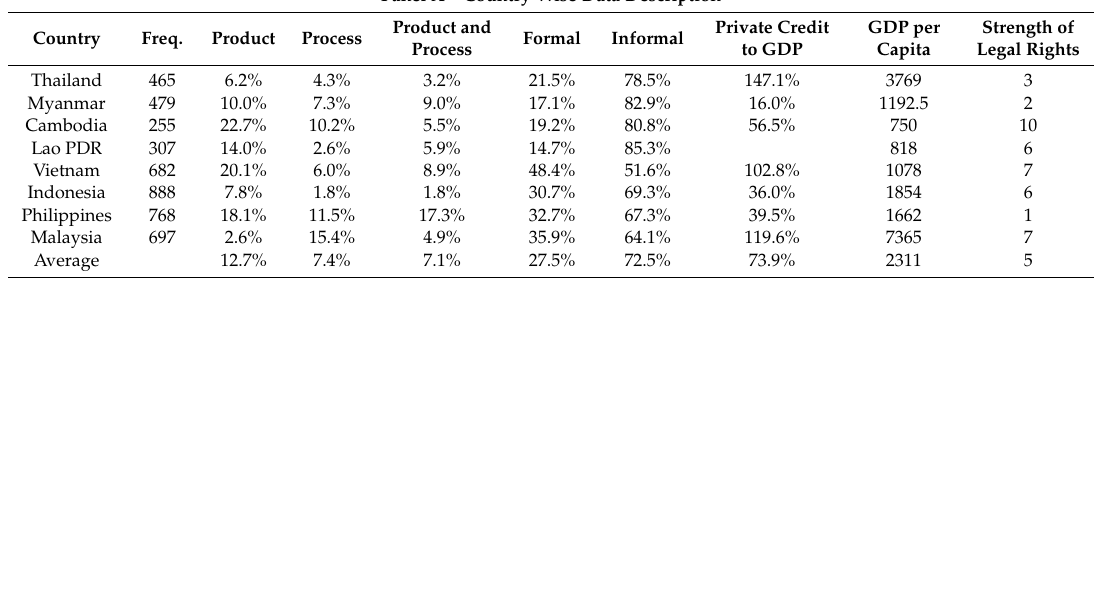
Table 1. Country- and industry-wise description innovation and financing choices. Panel A—Country-Wise Data